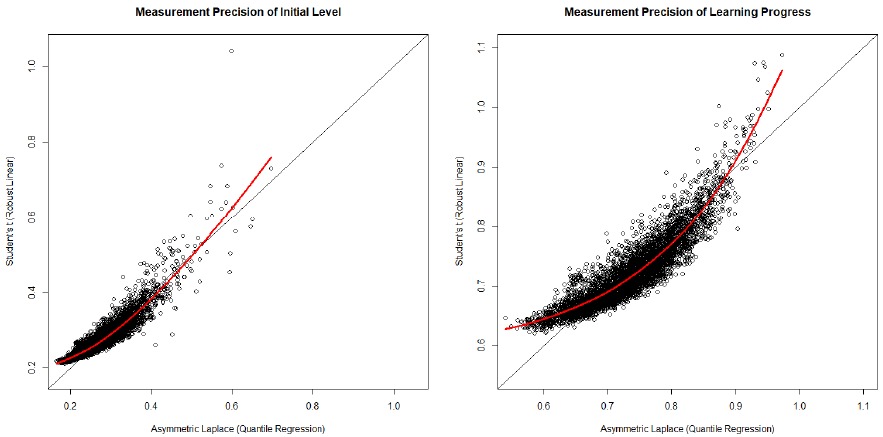
Figure 4. Bivariate scatter plots of measurement precision estimates. Red line = LOESS curve.